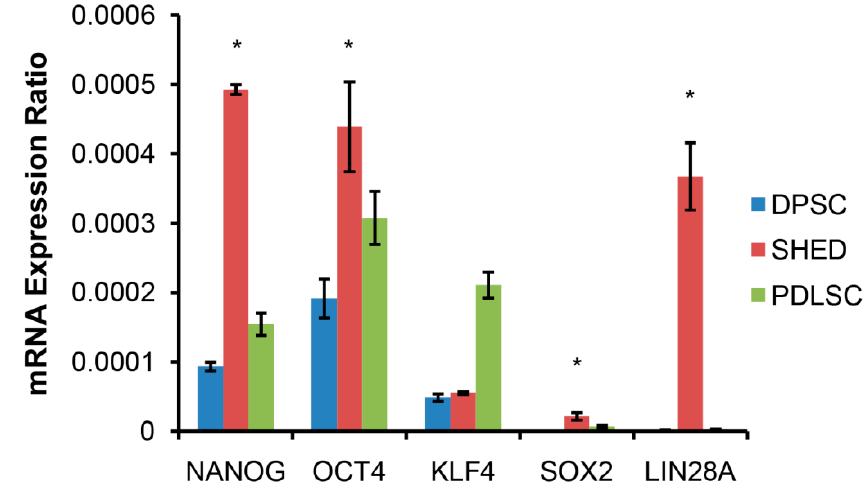
Figure 1. Expression of pluripotent transcription factors determined by quantitative PCR (qPCR) normalized with the level of GAPDH. DPSC: dental pulp stem cells; PDLSC: periodontal ligament stem cells; SHED: stem cells from human exfoliated deciduous tooth. SHED show a significantly stronger expression than other (asterisk * p < 0.05) markers, except KLF4. Gene Descriptions: NANOG, Nanog homeobox; OCT4, Octamer-binding protein 4; KLF4, Kruppel like factor 4; SOX2, SRY (sex determining region Y)-box 2; LIN28A, lin-28 homolog A; GAPDH, glyceraldehydes-3-phosphate dehydrogenase.